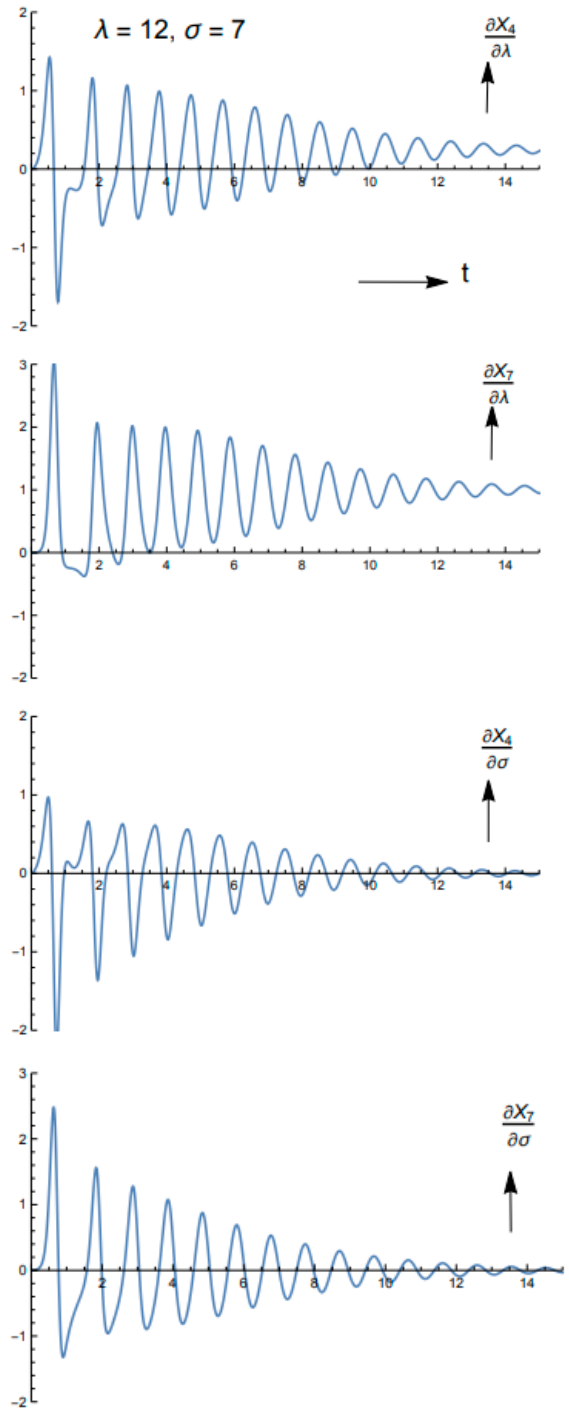
Figure 2. Forecast sensitivities of x 4 and x 7 with respect to ( λ , σ ) over time span [0, 14] for the non-chaotic regime with controls λ = 12, σ = 7 .